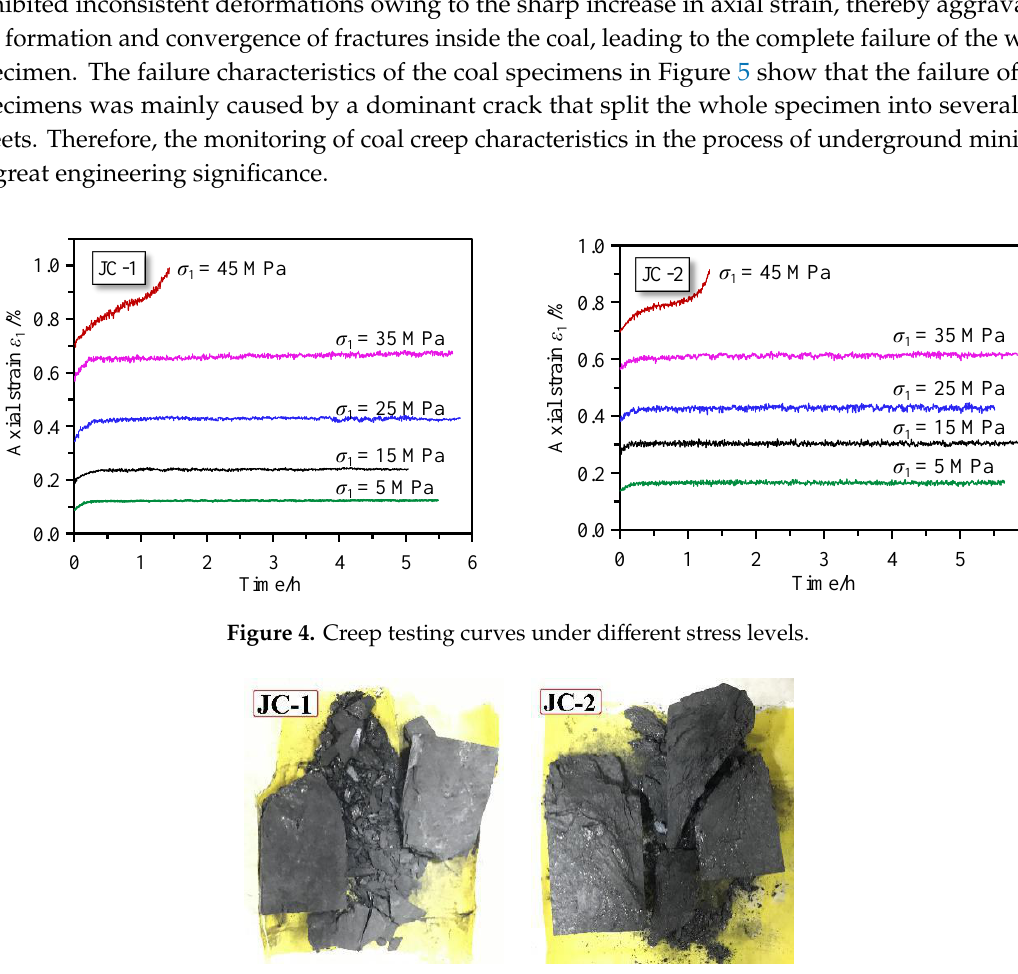
Figure 3. Creep testing curves of different coal specimens.